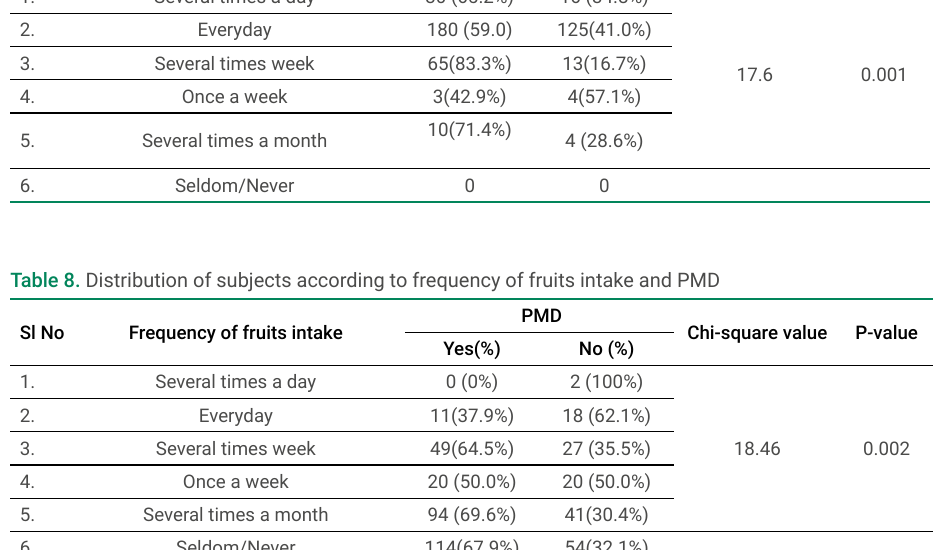
Table 7. Distribution of subjects according to frequency of vegetable intake and PMD Sl No Frequency of vegetable intake